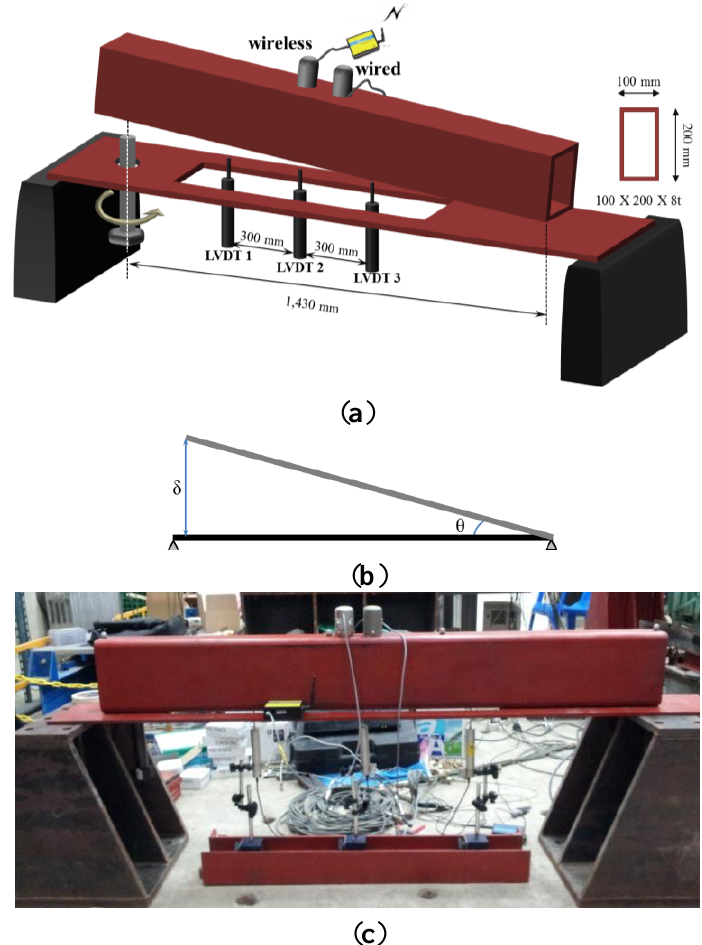
Figure 12. Test setup and instrumentation. ( a ) Schematic view of the test setup; ( b ) θ calculated from LVDTs; ( c ) Front view of the